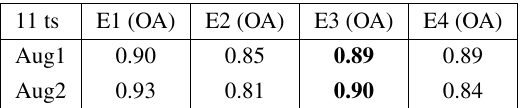
Table 3. Supervised benchmark - 14 time steps and 9 bands: Overall accuracy (OA) with all data; OA with 0% labels for 2018; with 5% labels and 10% for 2018.